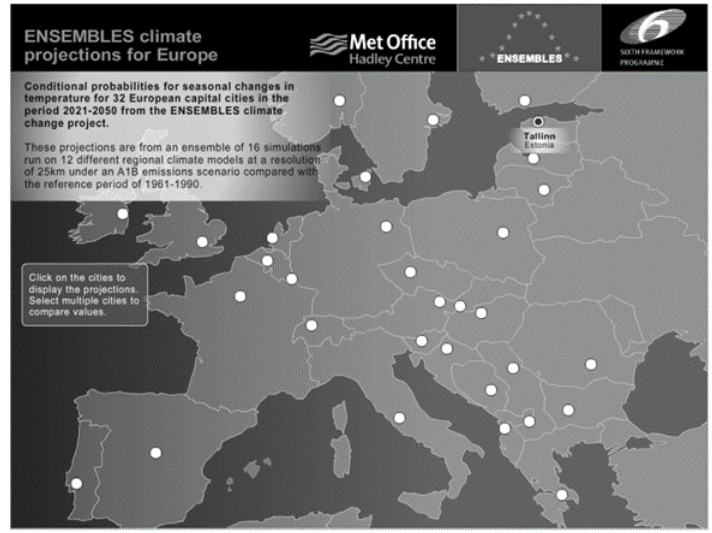
Fig. 3. Image of the ENSEMBLES climate projections map for Europe, a